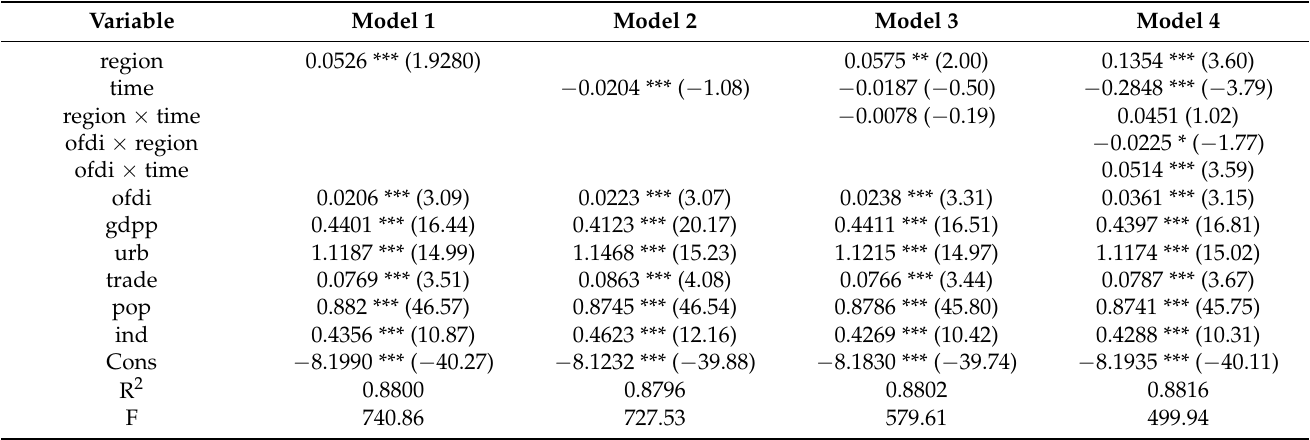
Table 6. The impact of China’s OFDI on energy consumption of host countries during